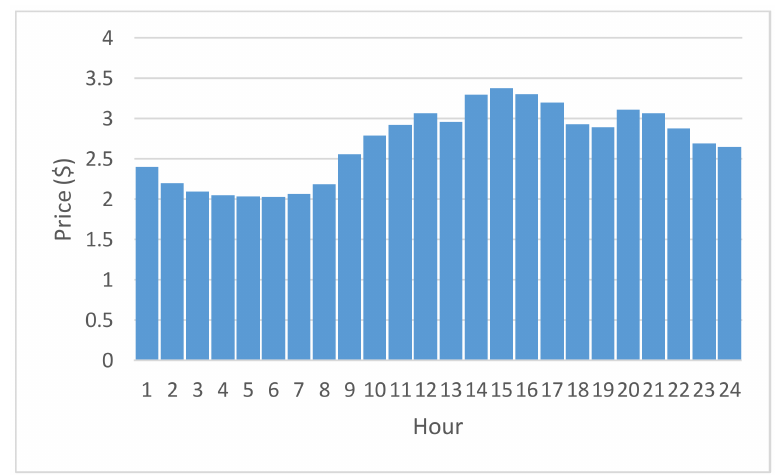
Figure 4. Assumed and simulated day-ahead RTP used to test the proposed method in this